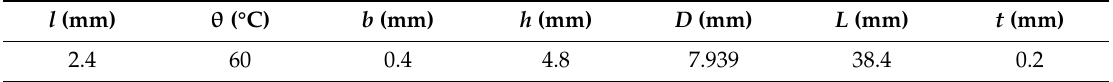
Table 1. Geometric parameters of the SMP stent (for Nc = 12, N L =